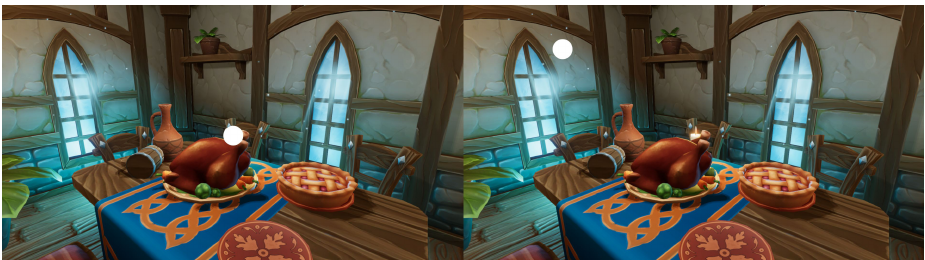
left image: in CrossG , players interact via a mouse (look around, pointing) and a keyboard (WASD-movement, crouching); the guidance (i.e., vignette effect) is driven by the current crosshair position that is pinned to the center of the screen, right image: in GazeG , players move in the same way as in CrossG (i.e., mouse and keyboard); in this condition, the guidance is decoupled from the screen’s center and is driven via the player’s gaze position. Note: gaze point is shown for demonstration purposes (i.e., no visual feedback on the current gaze position was